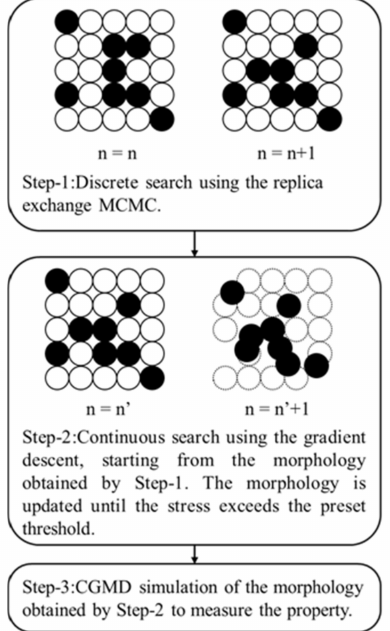
Figure 3. Flow chart of the developed morphology search method. The circles in Step 1 represent the filler candidate positions. The open circles and filled circles are the polymer and filler particles, respectively. The left figure in Step 2 is the initial state of this step. The right figure shows an updated filler configuration. CGMD simulation was carried out to measure the property in Step 3, because the properties evaluated in both Step 1 and Step 2 were merely predicted values by the CNN-based surrogate model for the efficient search. Thus, Step 3 was required to confirm if the morphologies obtained by the first 2 steps actually show the desired property.